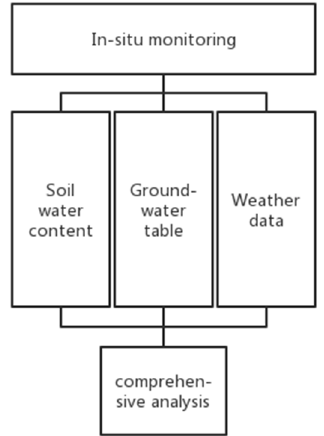
Figure 3. Data flow of the analyses of test data in the study area.